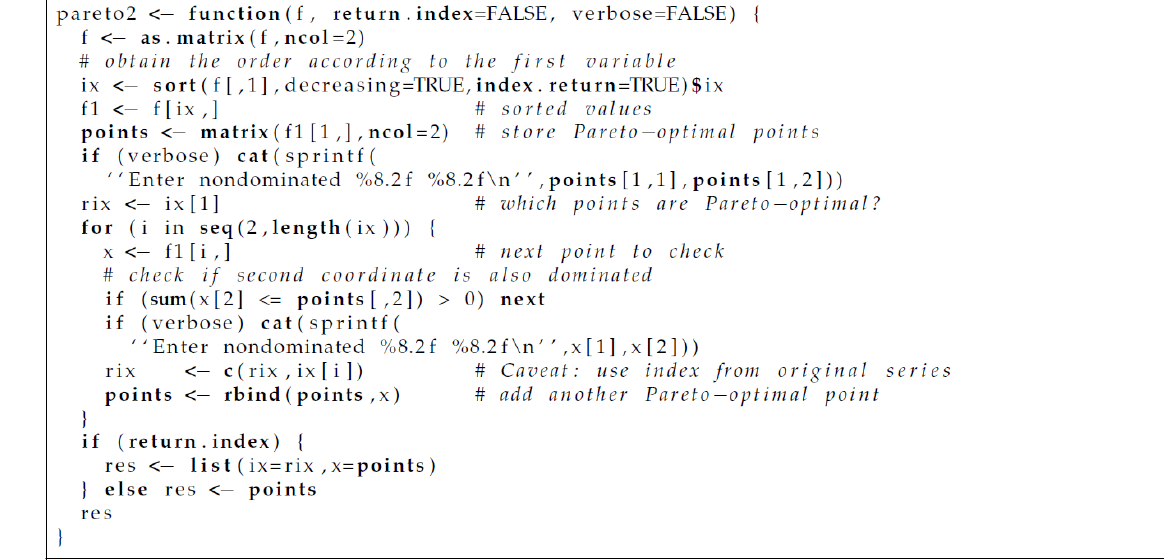
Figure A1. R code for calculating Pareto-optimal points of two-dimensional load